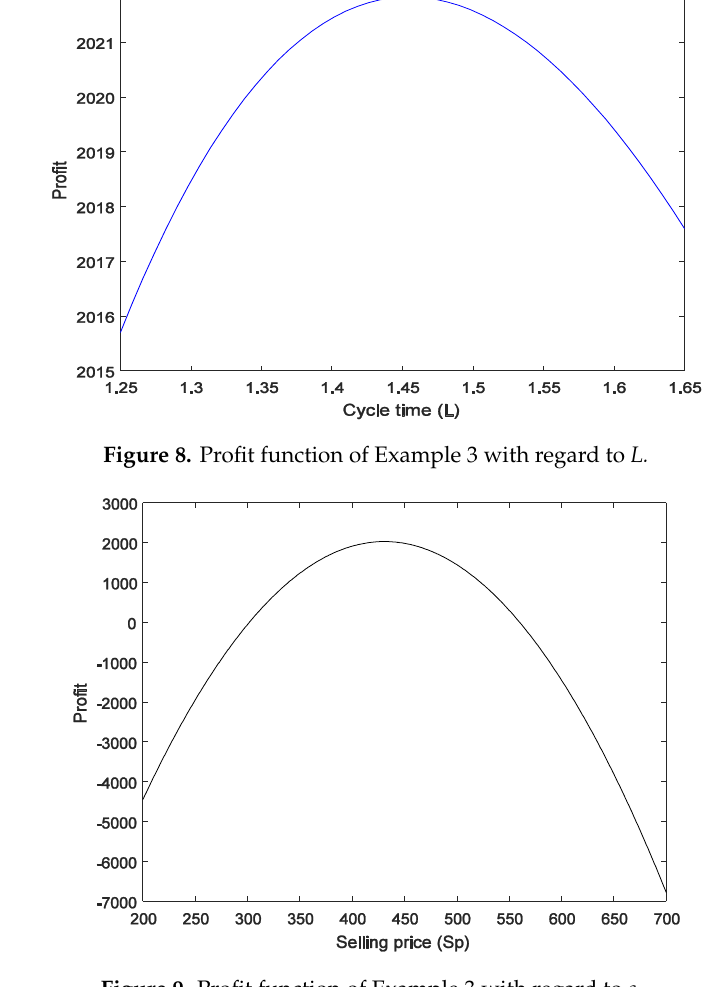
Figure 9. Profit function of Example 3 with regard to s p.